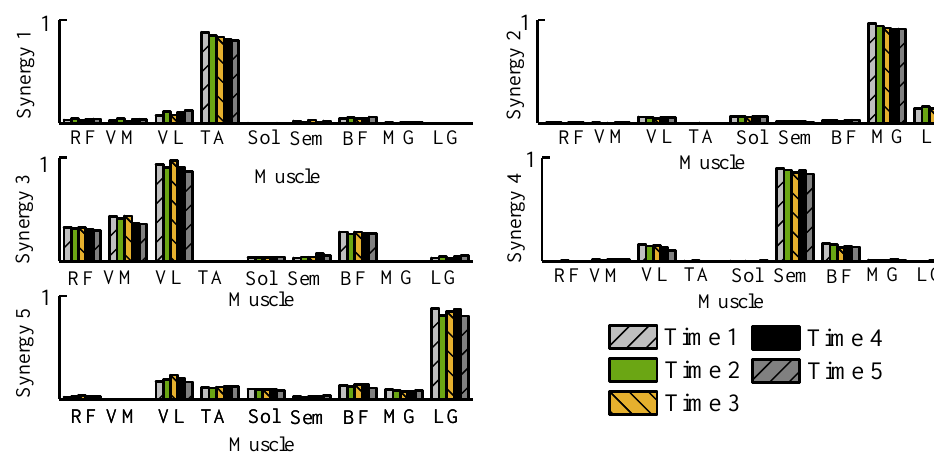
Figure 5. Similarity of synergy weights in different periods. Time 1 ∼ 5 represent the continuous time period, each period is 6 min of